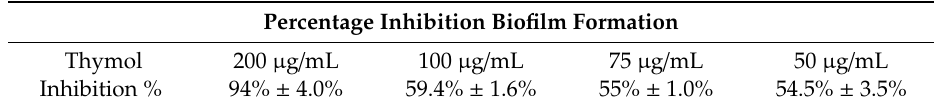
Table 2. Inhibition of E. coli 336 biofilm formation at sub-MIC concentrations of thymol. The averages from three independent experiments are reported with the SD